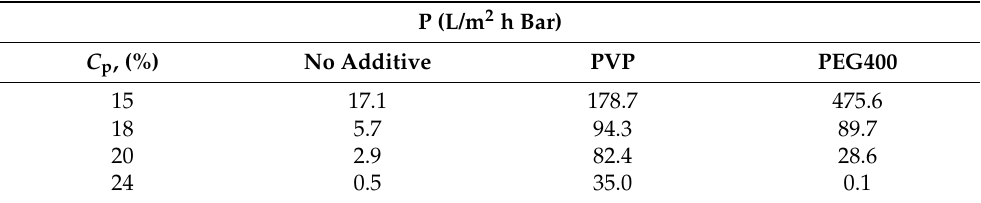
Table 6. Water permeability (P, L/m 2 h bar) of short-samples of hollow fiber PSf